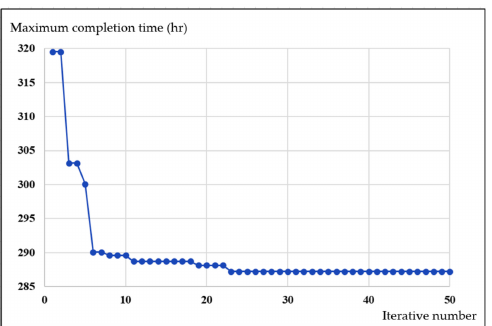
Figure 6. Decreasing trend of the maximum completion time in the iterative process of the algorithm.